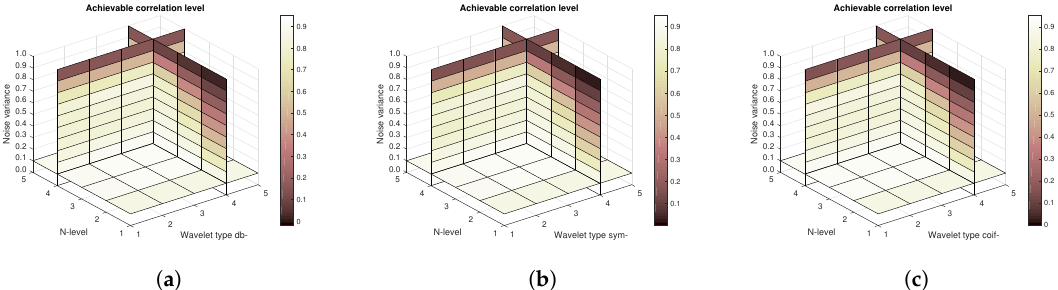
Figure 11. Mean achievable correlation levels for 60 MRI images with use of three mother wavelet families—from left Daubechies ( a ), Symlet ( b ) and Coiflet ( c ).